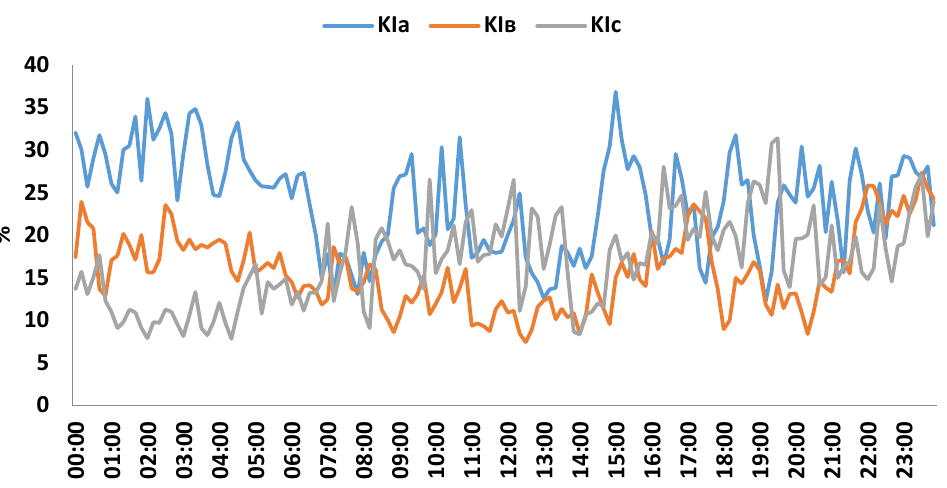
Fig. A4 - Change of coefficient non-sinusoidality of the current (apartment house)